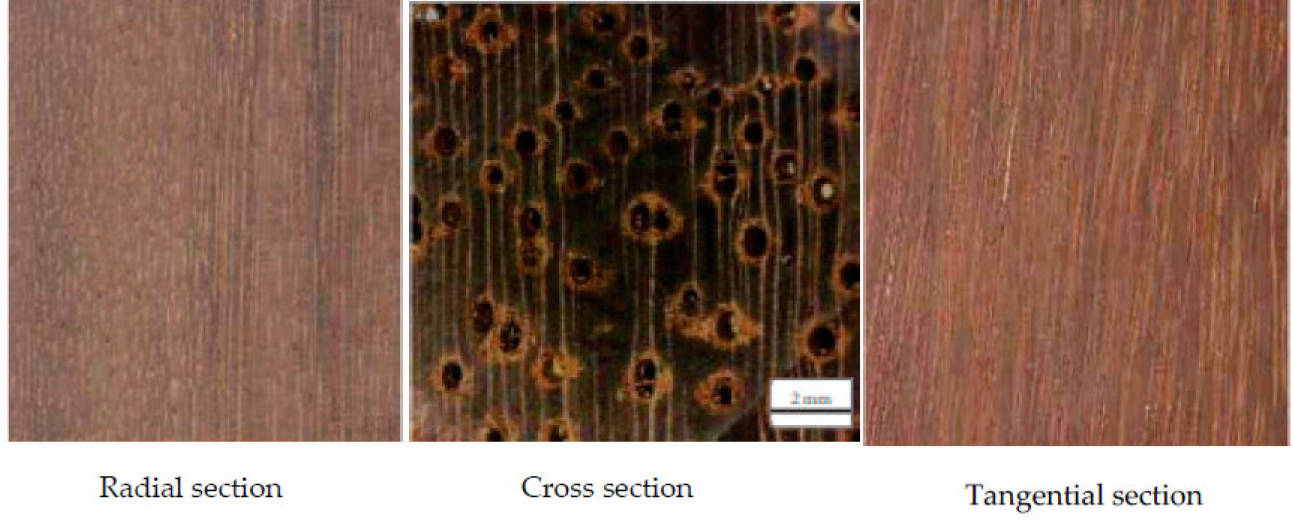
Figure 7. P. mooniana wood in macroscopic section, reproduced with permission from Krisdianto and Dewi